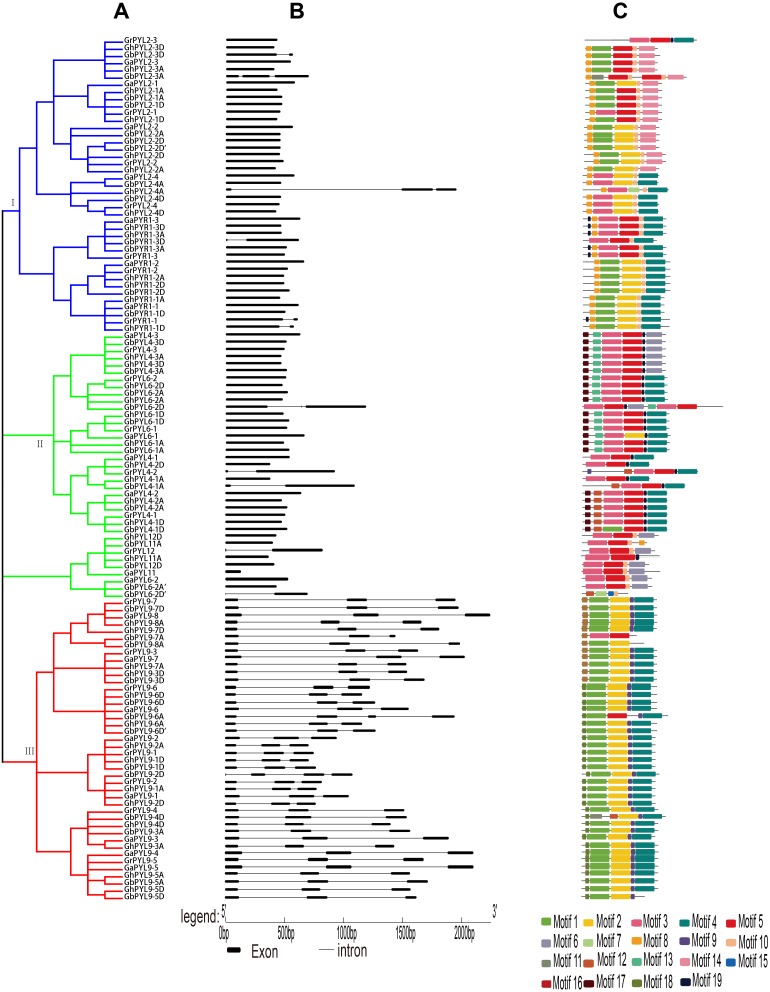
Phylogenetic relationships, gene architectures and conserved motifs of PYL genes in Gossypium.(A) The phylogenetic tree was constructed by the Neighbor-Joining (NJ) method, with 1,000 bootstrap replicates. The dark blue, green and red lines show the subfamily I, II and III, respectively. (B) Exon/intron architectures of Gossypium PYL genes. The color boxes indicate exons, and the color lines represent introns. The sizes of exons and introns can be calculated following the scale at the bottom. (C) Distributions of conserved motifs. The motifs are indicated by 19 different color boxes.